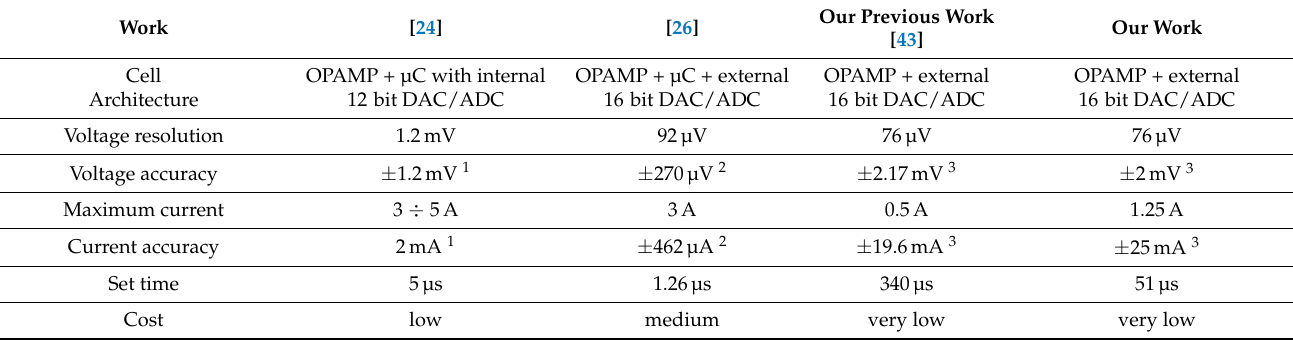
Table 3. Feature comparison of our work with literature